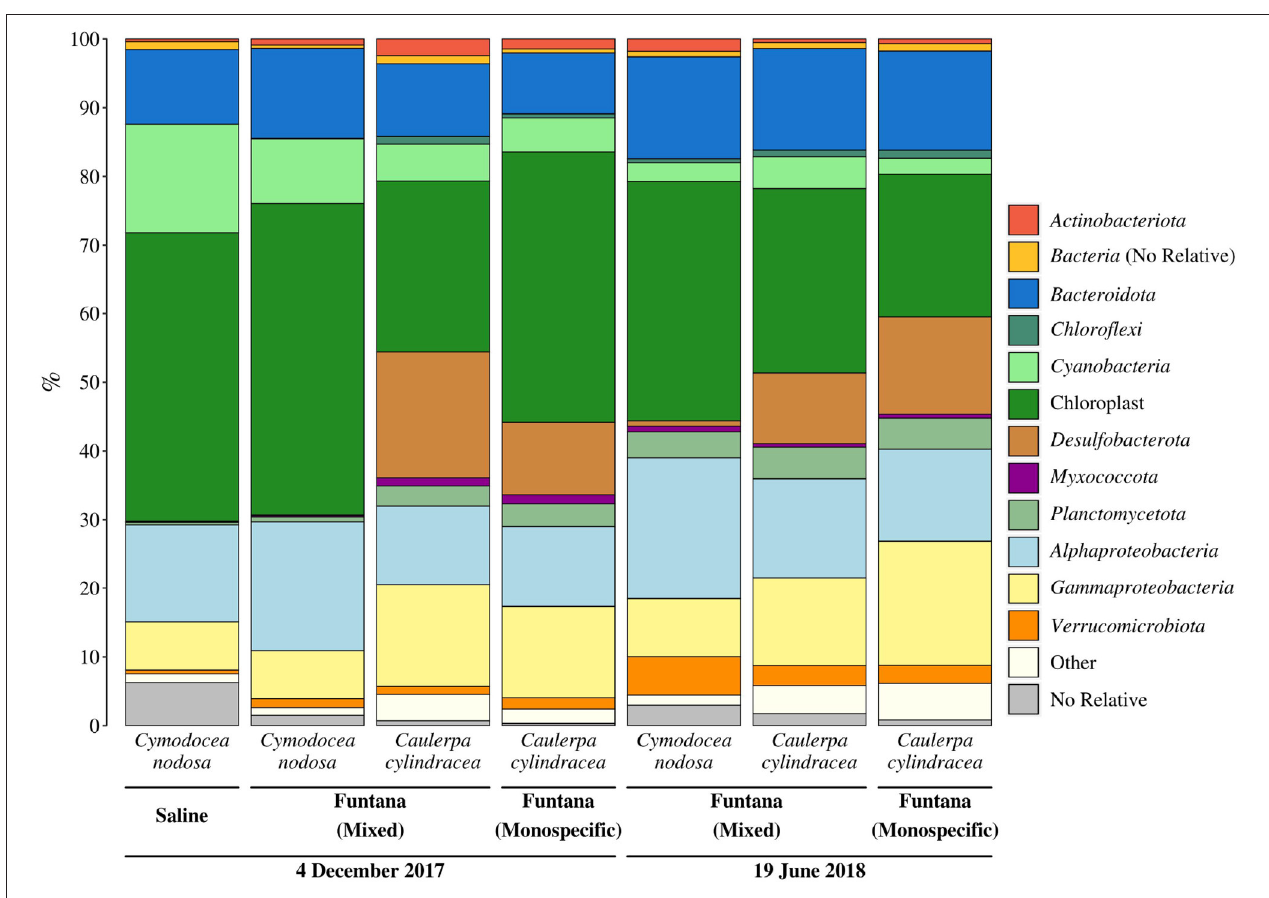
FIGURE 3 | Taxonomic classification and relative contribution of the most abundant ( ≥ 1%) bacterial and archaeal sequences from surfaces of two marine macrophytes ( C. nodosa and C. cylindracea ) sampled in the Bay of Saline and the Bay of Funtana (mixed and monospecific settlements) and in two contrasting seasons (December 4, 2017 and June 19,